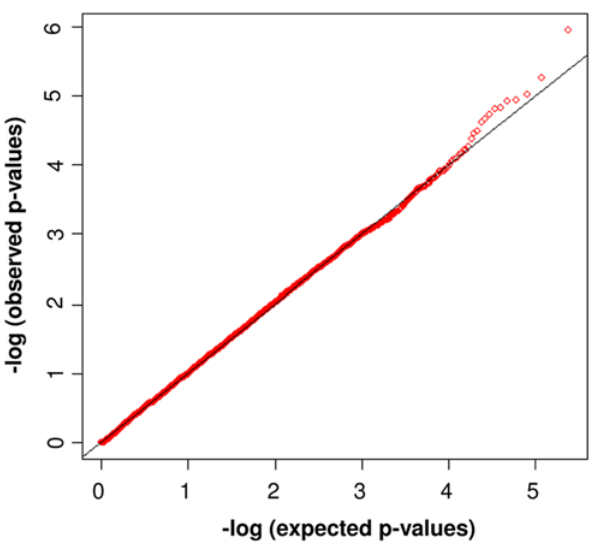
Figure 1. Quantile-Quantile Plot of Allelic Distributions. Allelic association analysis of expected versus observed P-values of 223,922 SNPs in 107 KD cases and 134 controls. Red dots showing deviations from the line of equality indicate either that the theoretical distribution was incorrect, or that the sample was contaminated with values generated by a true